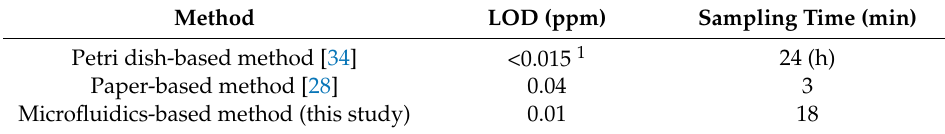
Figure 5. ( a ) Calibration curve of smartphone-based microfluidic colorimetric sensor for gaseous formaldehyde determination. ( b ) The corresponding reaction reservoir images of different concentrations. Table 1. A comparison of the AHMT-based methods for formaldehyde